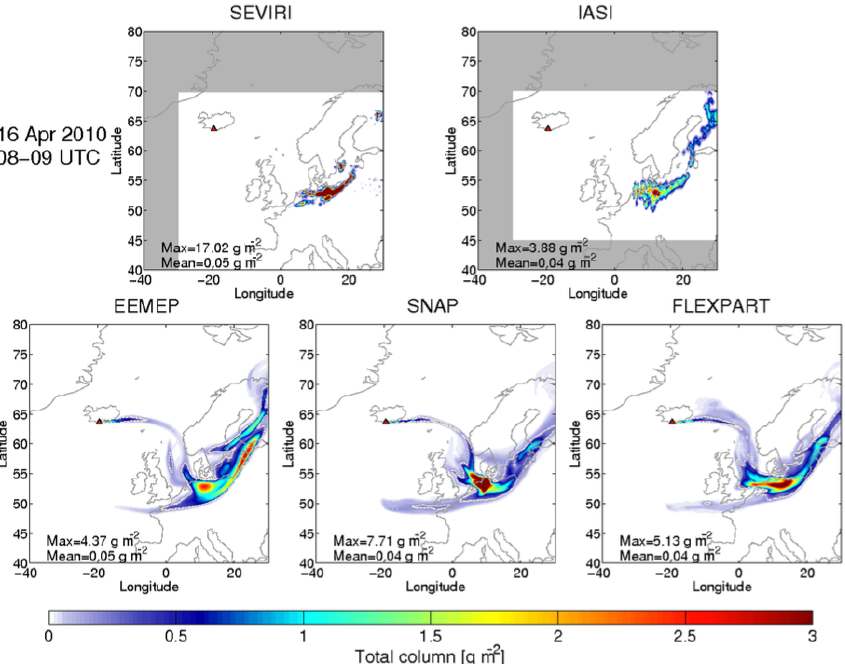
Figure 6. Mean ash column burdens from 08:00 to 09:00UTC on 16 April for SEVIRI and IASI satellite ash retrievals, and eEMEP, SNAP, and FLEXPART model simulations.